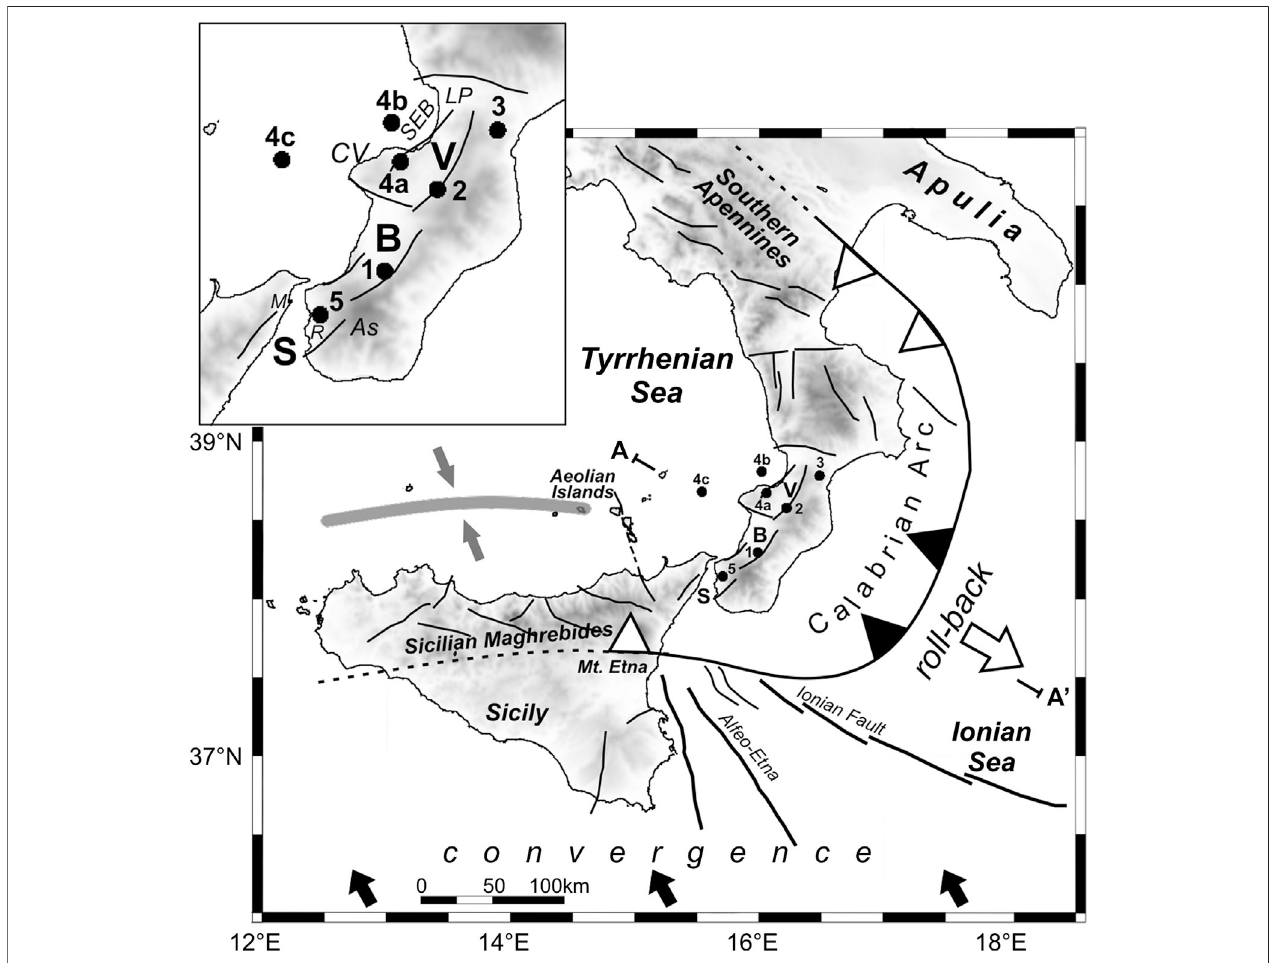
FIGURE 1 | Simpli fi ed tectonic map of the Calabrian Arc region redrawn with modi fi cations from Cadet and Funiciello (2004) and Polonia et al. (2011), with additional data from Dellong et al. (2018). The solid curve with the sawtooth pattern, pointing in the direction of subduction, indicates the present-day location of the Ionian subducting system. Black sawteeth indicate the location of the in-depth continuous subducting slab, white sawteeth show locations where the slab has already undergonedetachment(Nerietal.,2009;Nerietal.,2012;Orecchioetal.,2014).Thewhitearrowshowsthesenseofthegravity-inducedsubductingslabrollback. The black arrows schematize the sense of motion of Nubia relative to Europe in the study area (velocities of the order of 3 – 5 mm/yr; D ’ Agostino and Selvaggi, 2004; Devoti et al., 2008; Nocquet, 2012 and references therein). The gray belt and the converging arrows west of the Aeolian Islands in the southern Tyrrhenian sea show the present-day site of accommodation of convergence at the longitude of Sicily after detachment of the subduction slab and tectonic reorganization of the plate boundary. AA ′ approximatelyindicatestheNW-SEpro fi leusedforthecross-sectionsketchviewof Figure2 .S,B,andVstandforMessinaStraits,GioiaBasin,andMesimaValley, respectively. Dots withnumbers 1to5showthe epicenters oftheearthquakes ofmagnitude M over 6.5 which occurred since 1600in thesouthern Calabriasegmentof the Arc (see Table 1 for details). As (cid:1) Aspromonte, CV (cid:1) Capo Vaticano, LP (cid:1) Lamezia Plain, M (cid:1) Messina, R (cid:1) Reggio Calabria, SEB (cid:1) S. Eufemia